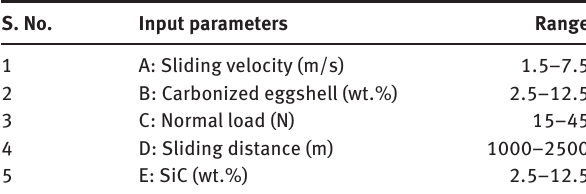
Table 2: Process parameters with their